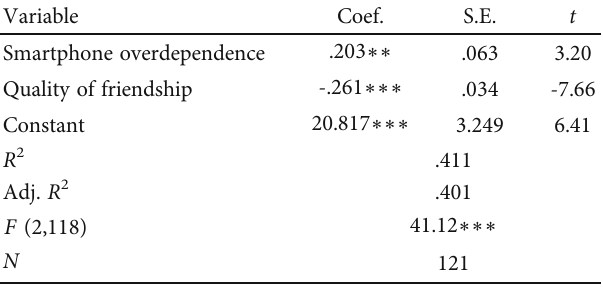
Table 4: Results of the multiple regression analysis among the variables.